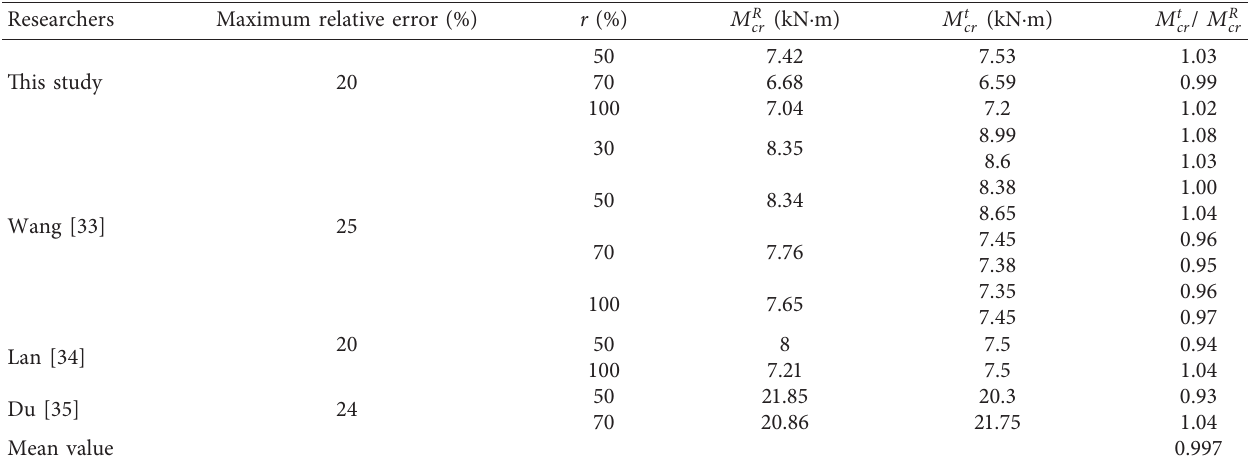
Table 10: Verification of the proposed